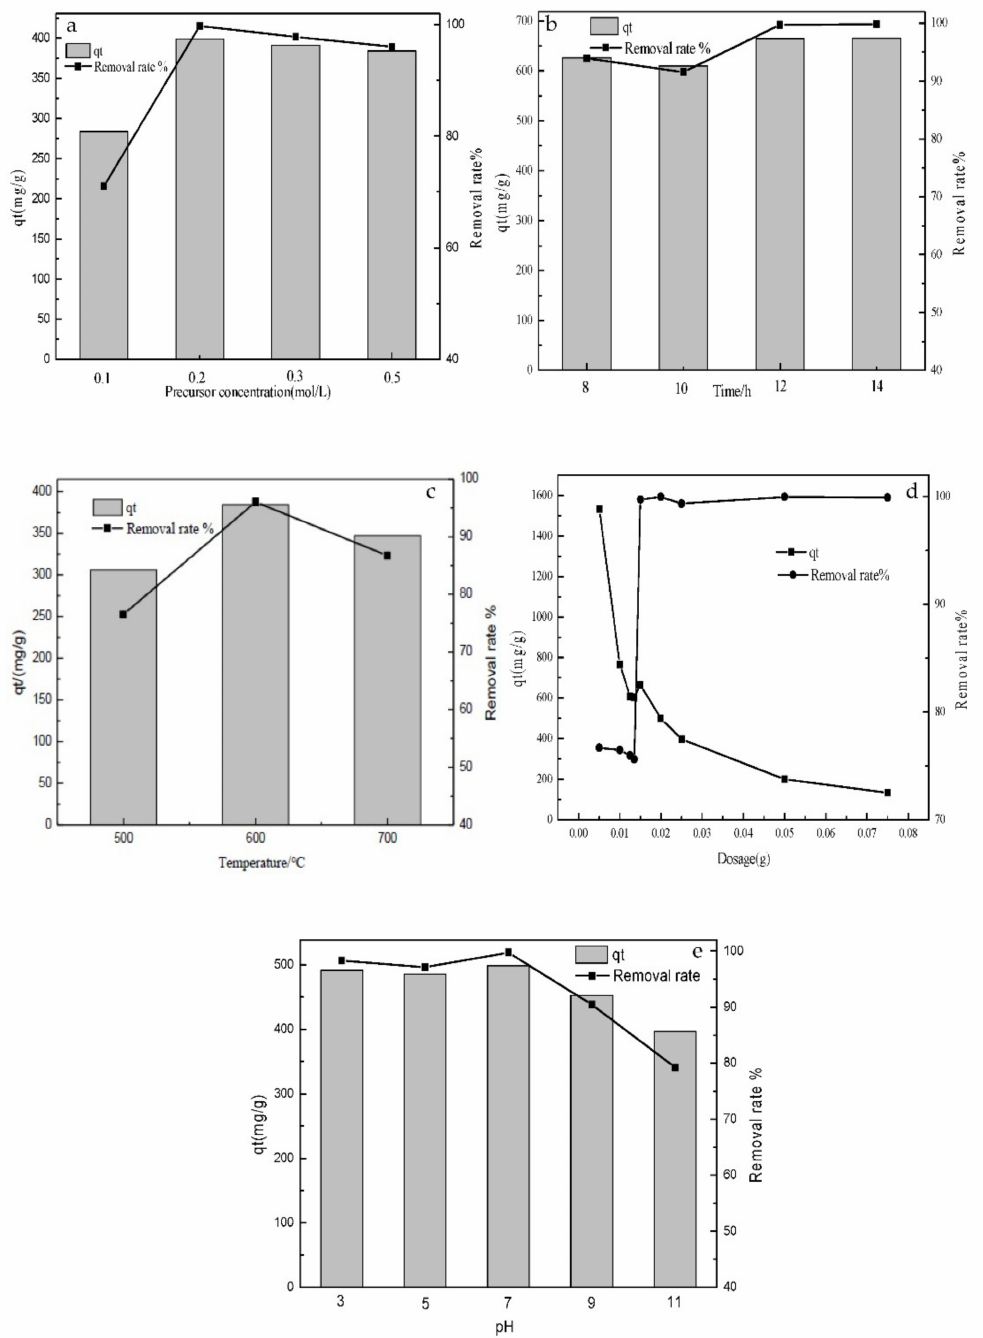
Figure 8. Effects of precursor concentration (mol/L) ( a ), reaction time (h) ( b ), calcination temperatures ( ◦ C) ( c ), adsorbent dose (g) ( d ), and pH ( e ) on the adsorption of sulfonated lignite by filter paper-templated Mg-Al metal